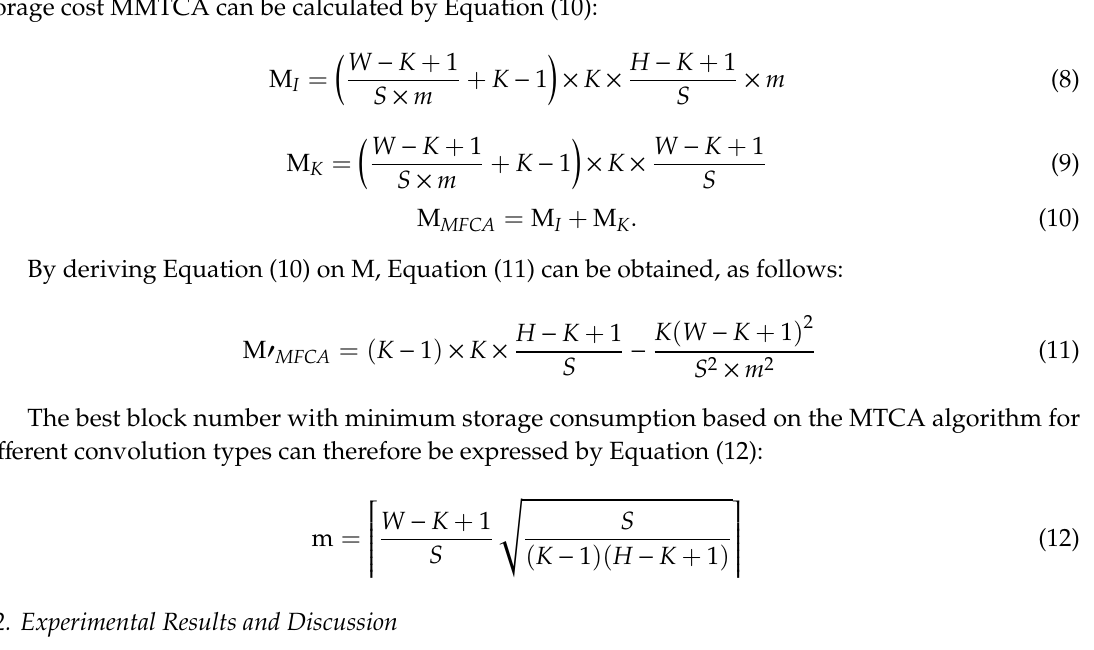
Table 1. Various types of convolutions and their optimal number of blocks.